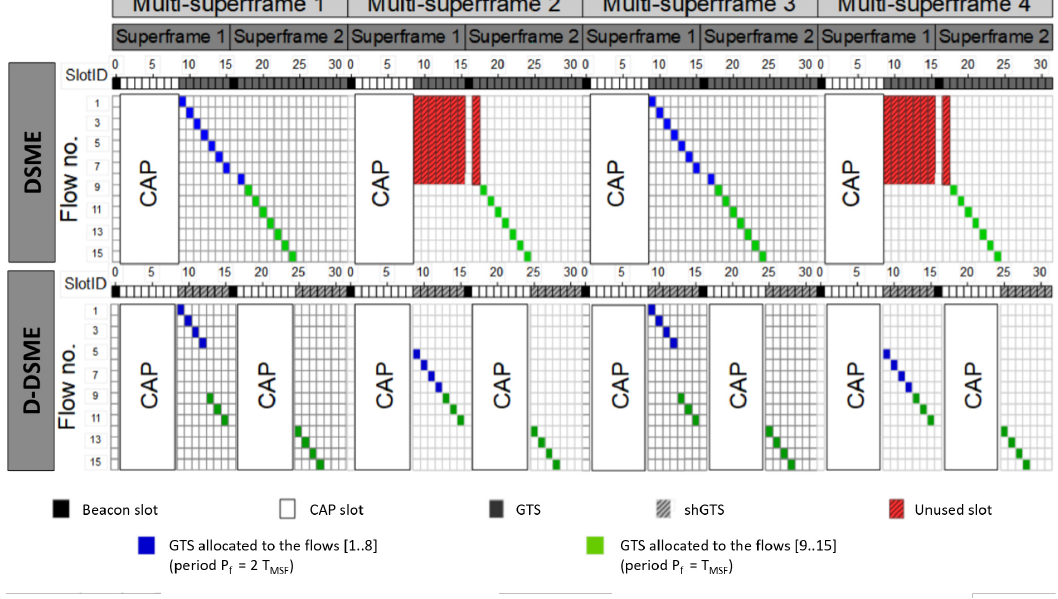
Figure 2. Scheduling example using DSME and